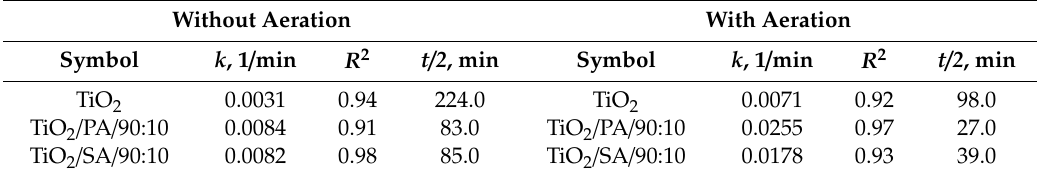
Figure 10. The efficiency of the chlorfenvinphos photodegradation in the presence of selected photocatalysts, with and without additional aeration. Conditions of experiment: C 0 = 1.0 mg / L; D c = Table 6. E ff ect of aeration of systems on the process